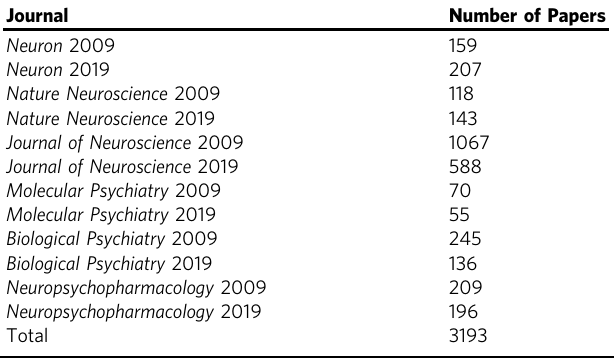
Table 1 The number of papers examined that were published in 2009 or 2019 in the six journals